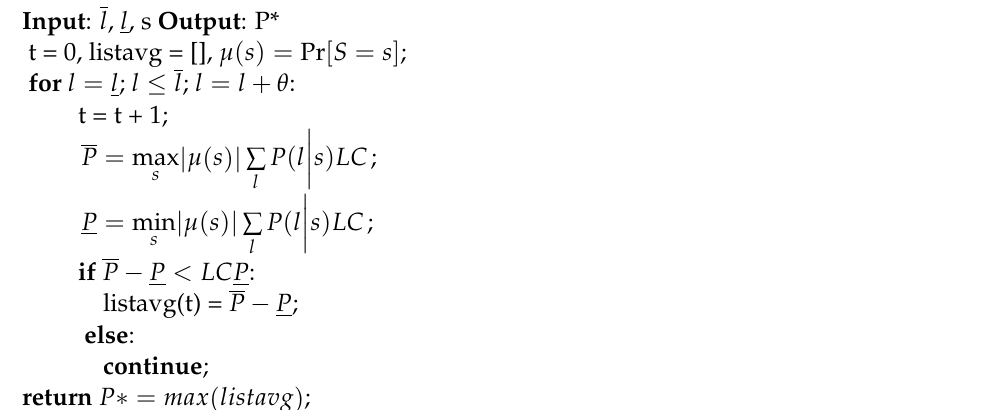
Algorithm 2. OSINT-based perturbation for artificial